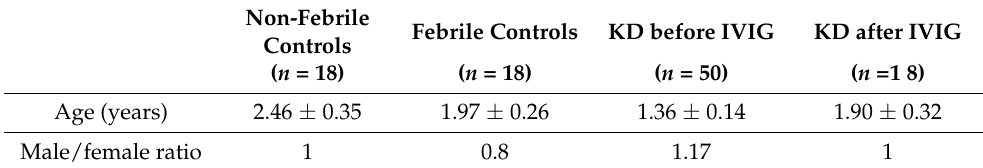
Table 1. Demographic characteristics of the subjects for establishing KDmarkers online tool.